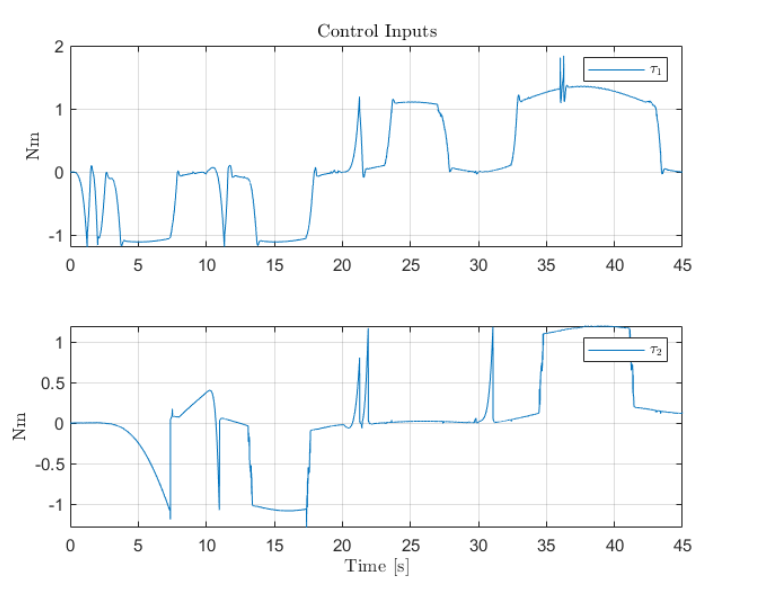
Figure 19. Control inputs for the servo-actuators of Links 1 and